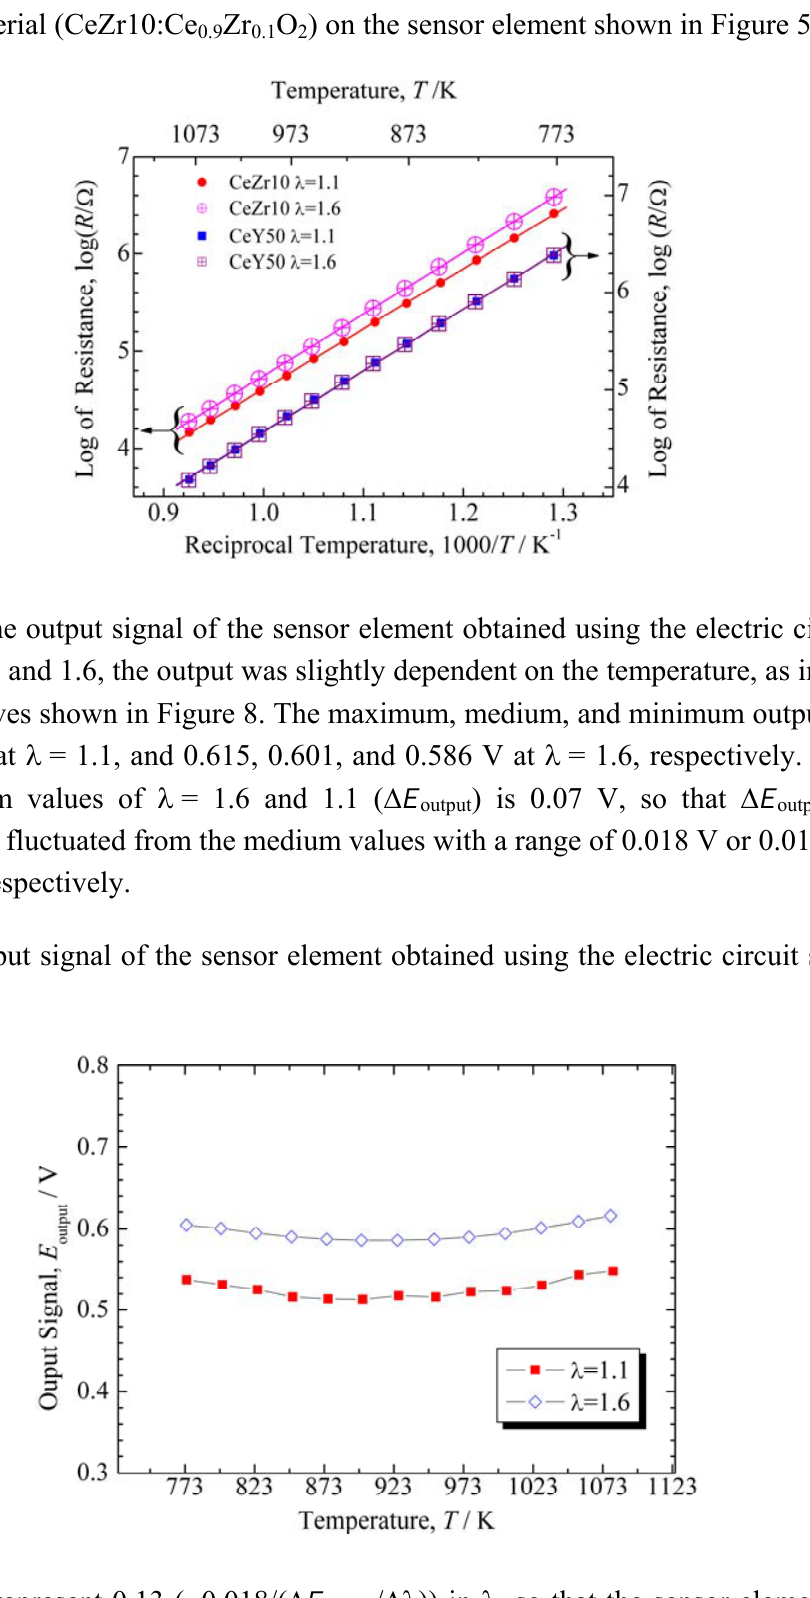
Y O ) and 0.5 0.5 2- 